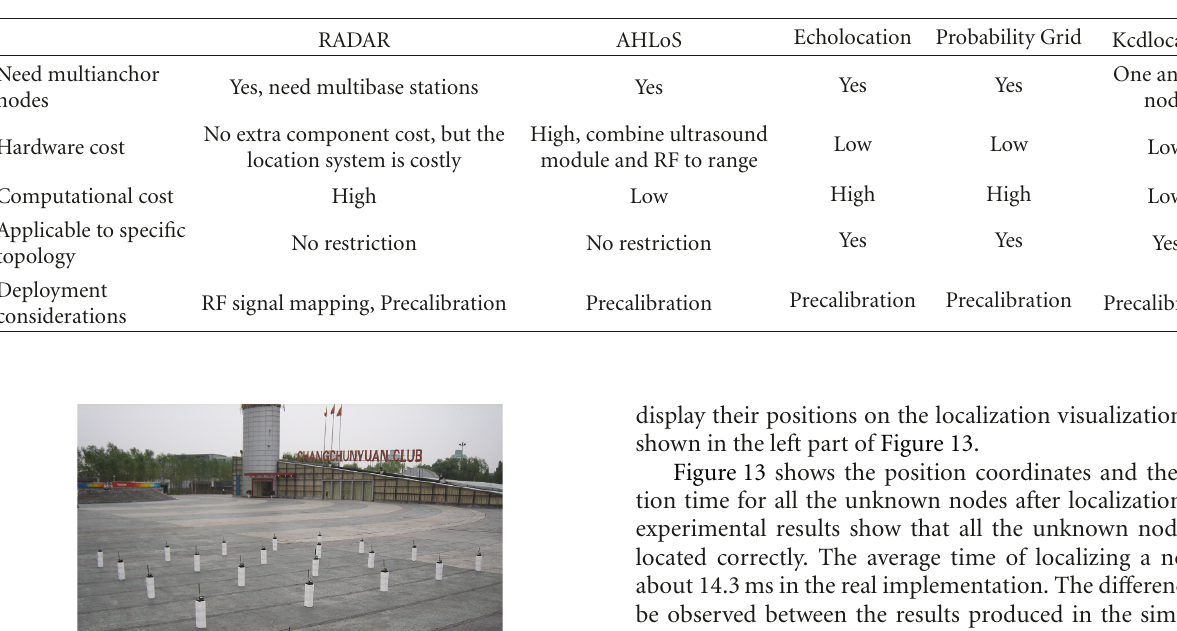
Table 1: Comparison of other location systems with Kcdlocation.